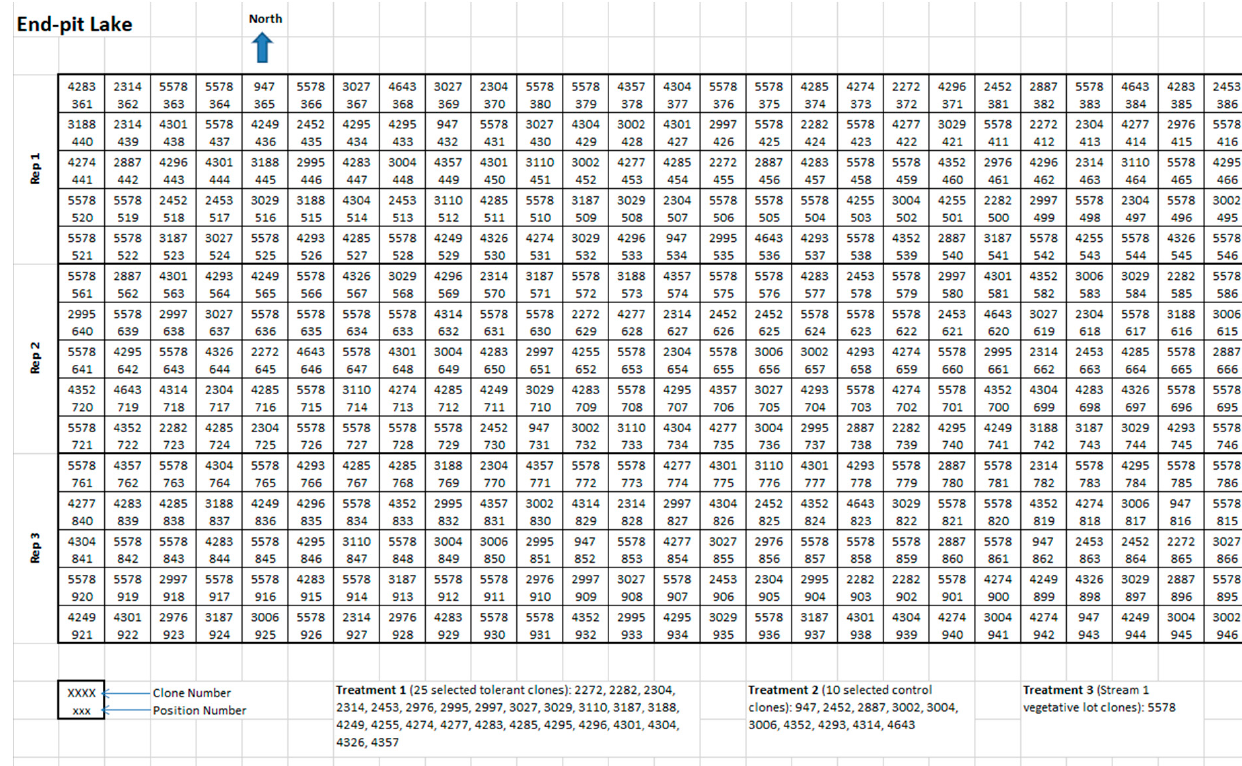
Figure A3. Map of the field trial site showing individual tree locations within each block (rep).